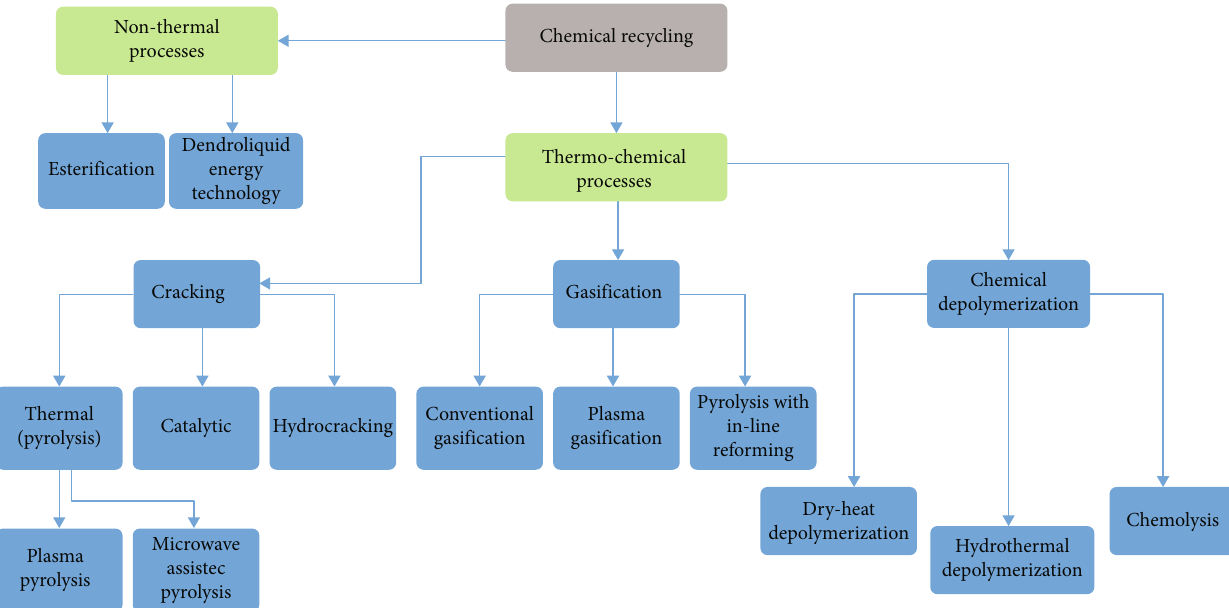
Figure 3: Chemical recycling